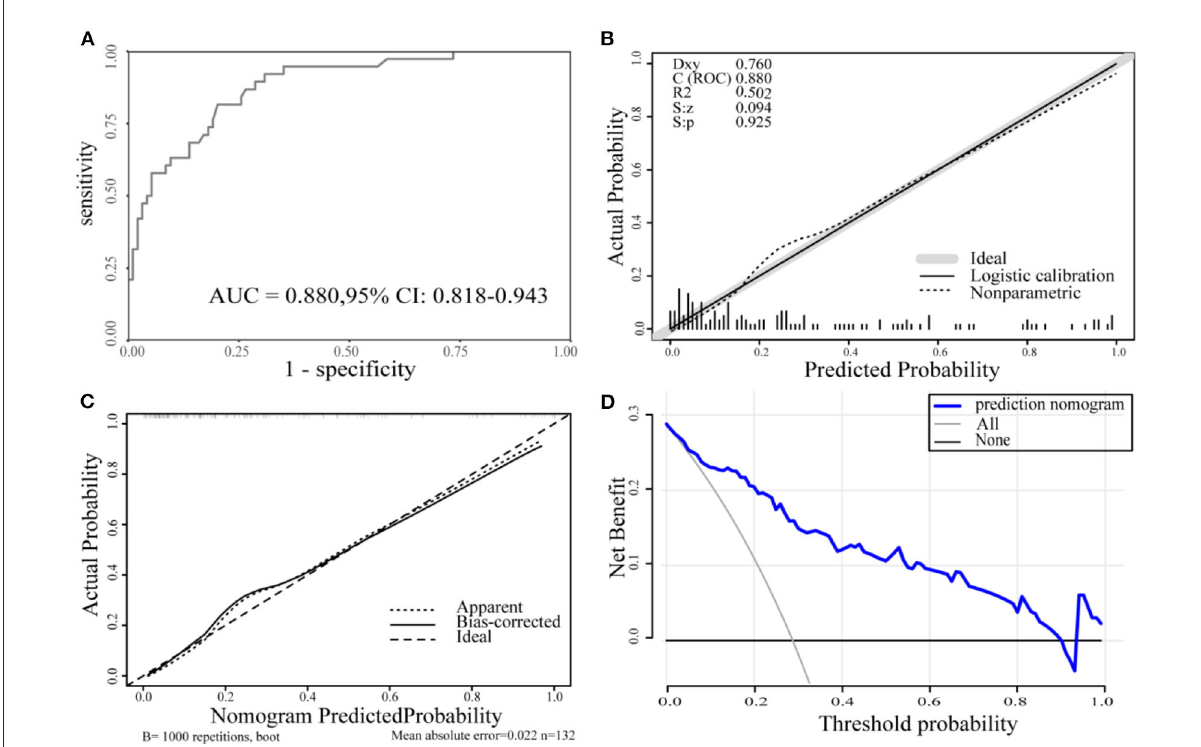
FIGURE3 (A) The ROC curve for the nomogram. AUC = 0.880 (95% CI, 0.818-0.943). (B) The calibration curve for the nomogram. p = 0.925 > 0.05. (C) The calibration curve for the nomogram with 1,000 bootstrap resamples. (D) DCA of the nomogram. The solid blue line represents the nomogram. Decision curves show that when the threshold probability is > 0.01, the nomogram achieves the greatest benefit compared with all treatment and no treatment strategies. ROC, the receiver operating characteristic curve; AUC, the area under the curve; DCA, decision curve